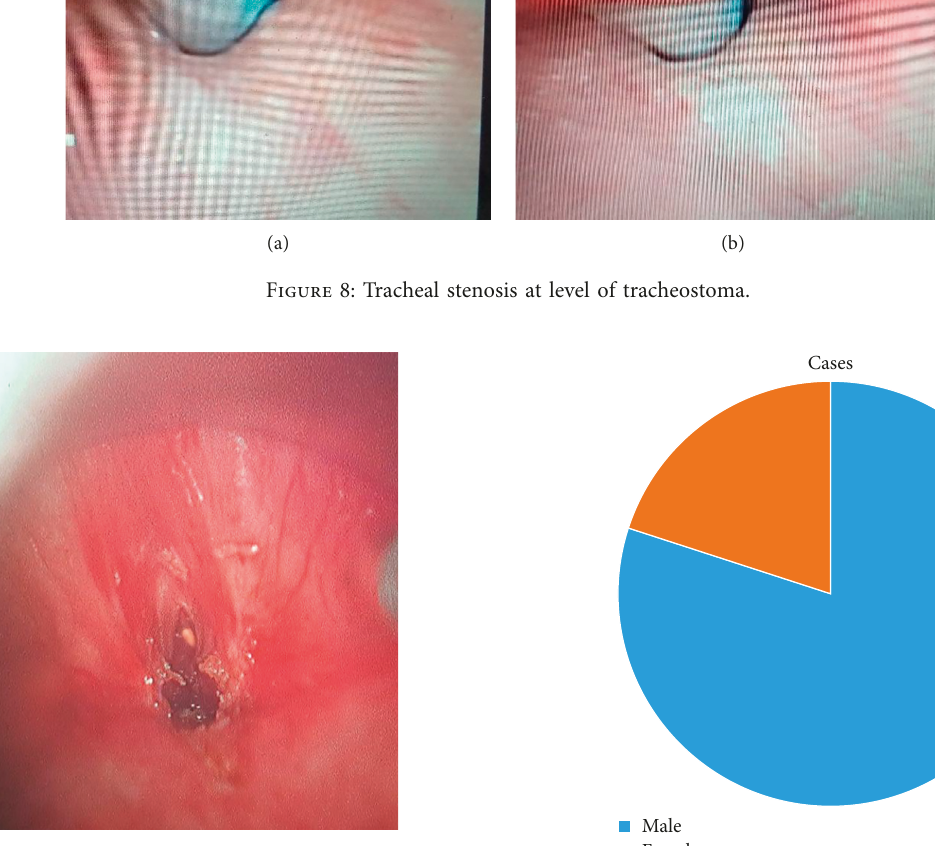
Figure 9: Laser excision of stenosis.